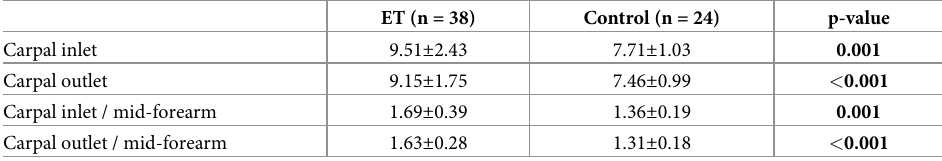
Table 2. Comparison of mCSA at the wrist level between patients with ET and controls.